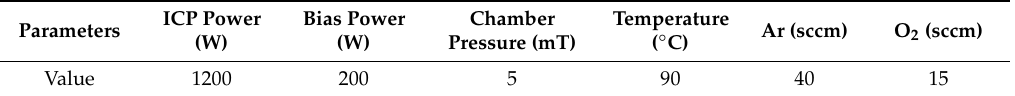
Table 5. The parameters of clean step.